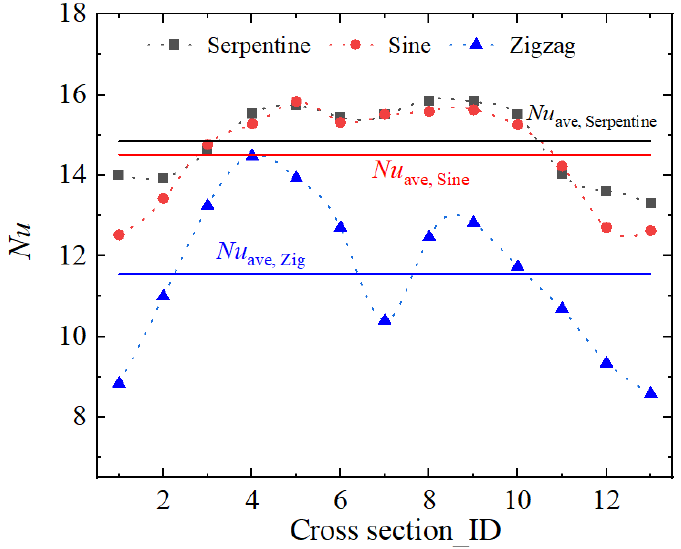
Figure 20. Profiles of local and average heat transfer coefficient in one period ( Re in = 2500, A = tan 57.5° , q = 1 kW/m 2 , and 29% Xe).